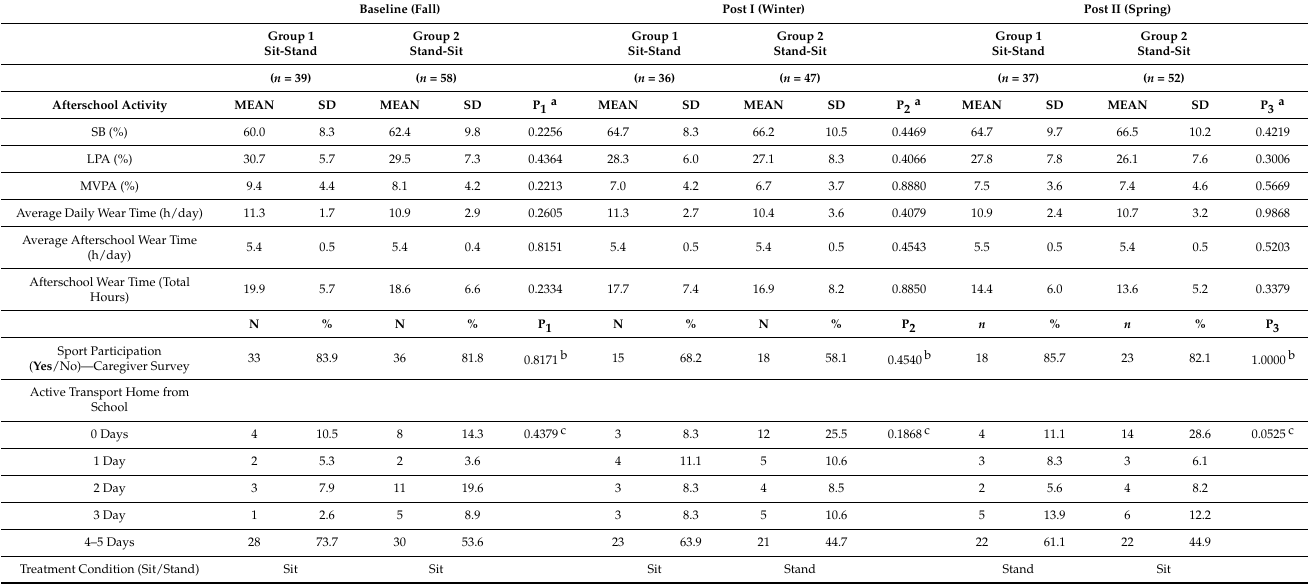
Table 3. Physical activity and sedentary behavior characteristics afterschool in those using a sitting desk versus a stand-biased desk (mean